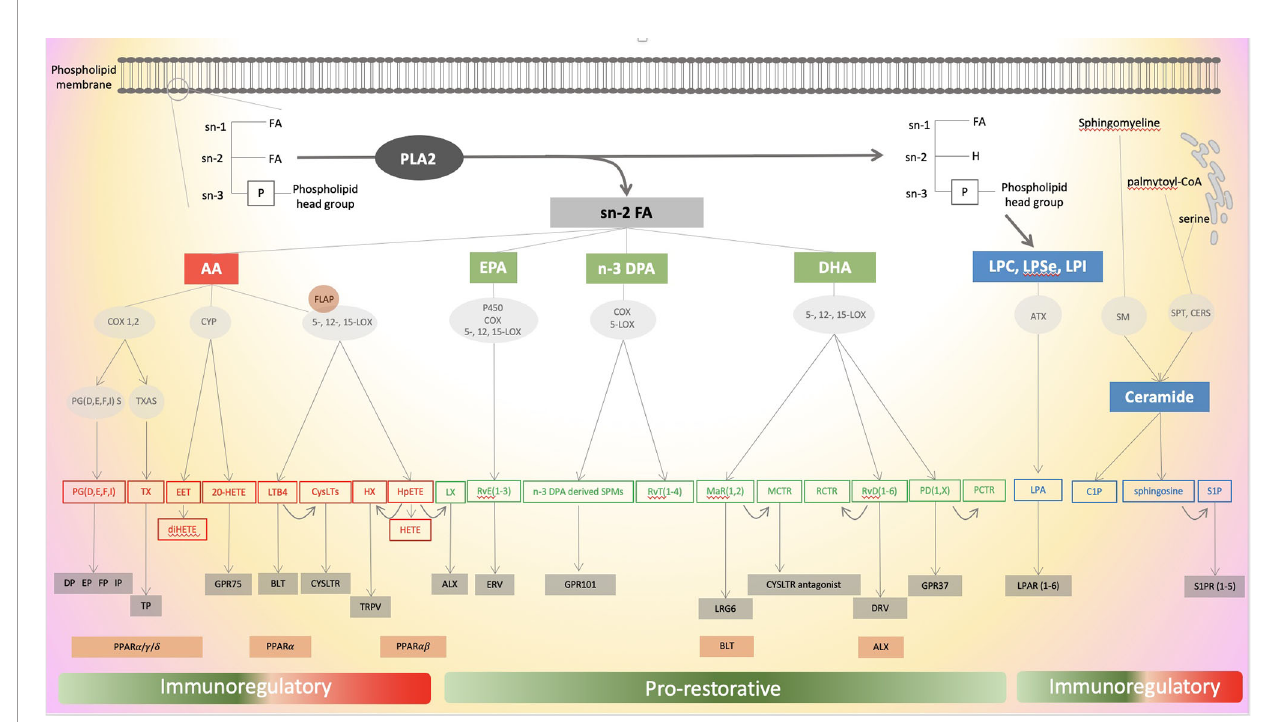
FIGURE 1 | Schematic illustration of the different pathways of eicosanoids, specialized pro-resolving mediators (SPMs) and lysophospholipids metabolism. Eicosanoid ’ s mediators are in red, SPMs mediators in green and lysophospholipids mediators in blue. Enzymes are in round grey areas, common receptors in rectangular grey areas and alternative receptors in rectangular orange areas. ATX, autotaxin; BLT, leukotriene receptor, C1P, ceramide-1-phosphate; CERS, ceramide synthases; COX, cyclooxygenase; PLA2, phospholipase A2; CYP, cytochrome P450; CysLTs, cysteinyl leukotrienes; CysLTR, cysteinyl leukotrienes receptors; DHA, docosahexaenoic acid; DP, prostaglandin D receptor; DPA, docosapentaenoic acid; EET, epoxyeicosatetraenoic acid; EP, prostaglandin E receptor; EPA, eicosapentaenoic acid; ERV, E-series resolvin receptor; FA, fatty acid; FLAP, 5-LOX activating protein; FP, prostaglandin F receptor; GPR, G protein-coupled receptor; HETE, hydroxy eicosatetraenoic acid; HpETE, hydroperoxy eicosatetraenoic acid; Hx, hepoxilin; IP, prostacyclin receptor; LGR6, leucine-rich repeat containing G protein-coupled receptor 6; LTB4, leukotriene B4; LOX, lipoxygenase; LPA, lysophosphatidic acid; LPAR, lysophosphatidic acid receptor; LPC, lysophosphatidylcholine; LPSe, lysophosphatidylserine; LPI, lysophosphatidylinositol; LX, lipoxin; MaR, maresin; MCTR1, maresin conjugates in tissue regeneration 1; PCTR, protectin conjugates in tissue regeneration; PD, protectins; PG, prostaglandin; PGS, prostaglandin synthase; PPAR, peroxisome proliferator-activated receptor; RvD, D-series resolvin; RvE, E-series resolvin; RvT, thirteen-series resolvin; S1P, Sphingosine-1-phosphate; S1PR, Sphingosine-1-phosphate receptor; SM, sphingomyelinase; SPMs, specialized pro-resolving mediator; SPT, serine -palmitoyl transferase; TRPV, transient receptor potential vanilloide 1; TP, thromboxane receptor; Tx, thromboxane; TXAS, TxA